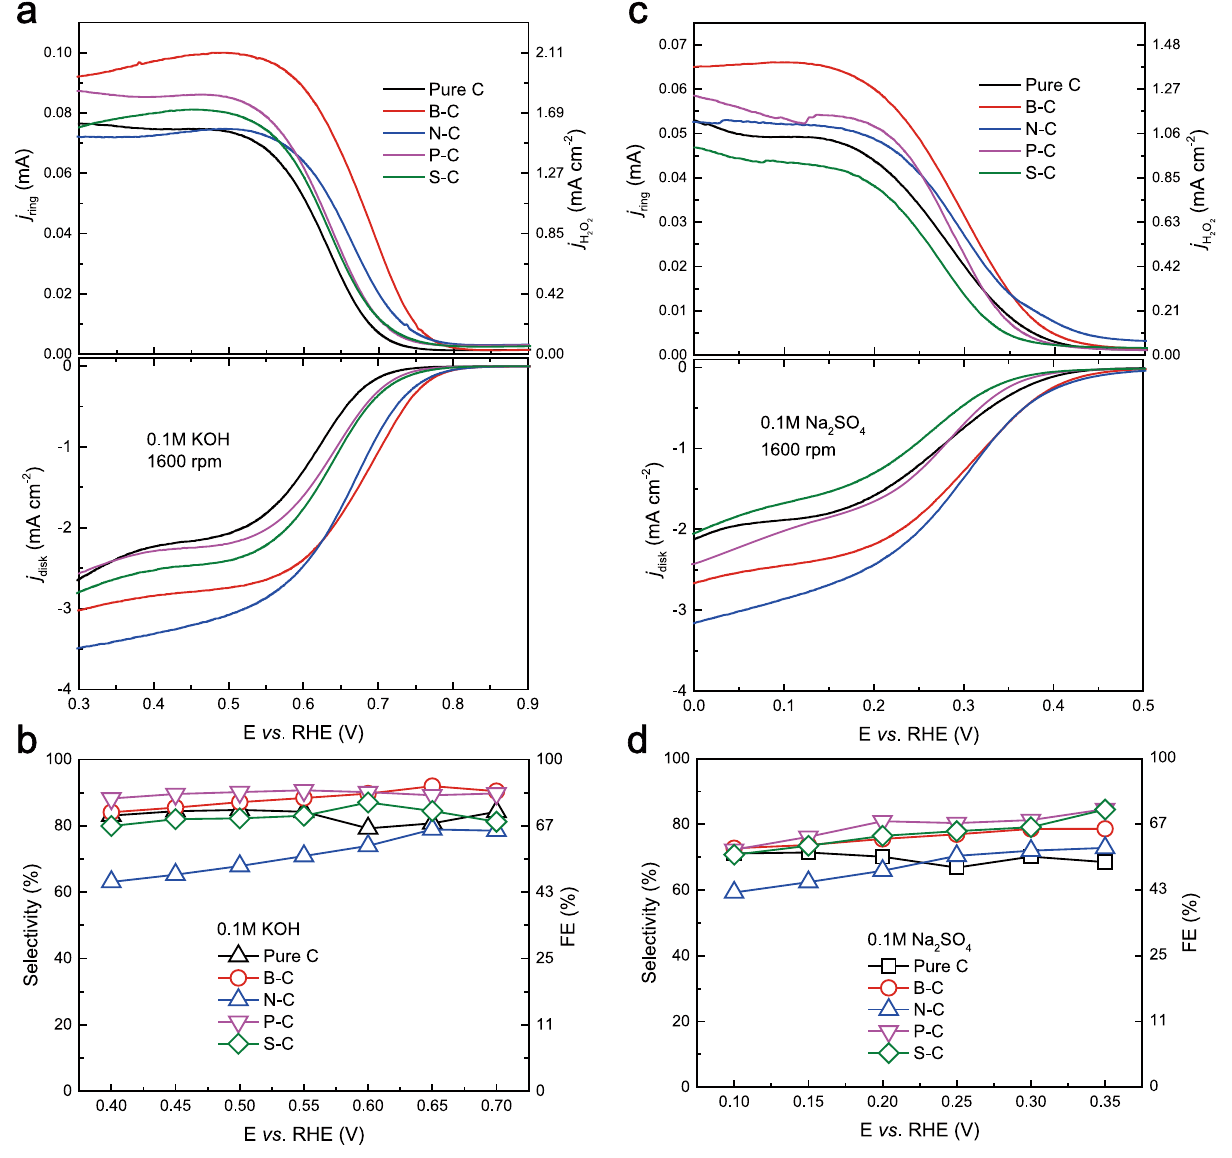
Fig. 1 ORR performance of catalysts by RRDE. ORR performances of catalysts by RRDE in 0.1M KOH ( a , b ) and 0.1M Na 2 SO 4 ( c , d ). a , c Linear sweep voltammetry (LSV) of Pure C and B, N, P, S-doped carbon catalysts recorded at rotation rate of 1600 rpm and potential scan rate of 5 mV s − 1 (lower panel), together with the detected H 2 O 2 currents on the Pt ring electrode (upper panel) at a fi xed potential of 1.2 V vs. RHE. The corresponding H 2 O 2 partial current densities are also plotted on the right y -axis. b , d H 2 O 2 molar selectivity (left y -axis) and Faradaic ef fi ciency (right y -axis) during the potential sweep for different catalysts in 0.1M KOH and 0.1M Na 2 SO 4 , respectively. Note that the right y -axis for Faradaic ef fi ciency is not linearly scaled, and the detailed relation between H 2 O 2 molar selectivity and H 2 O 2 Faradaic ef fi ciency is included in Supplementary Fig.